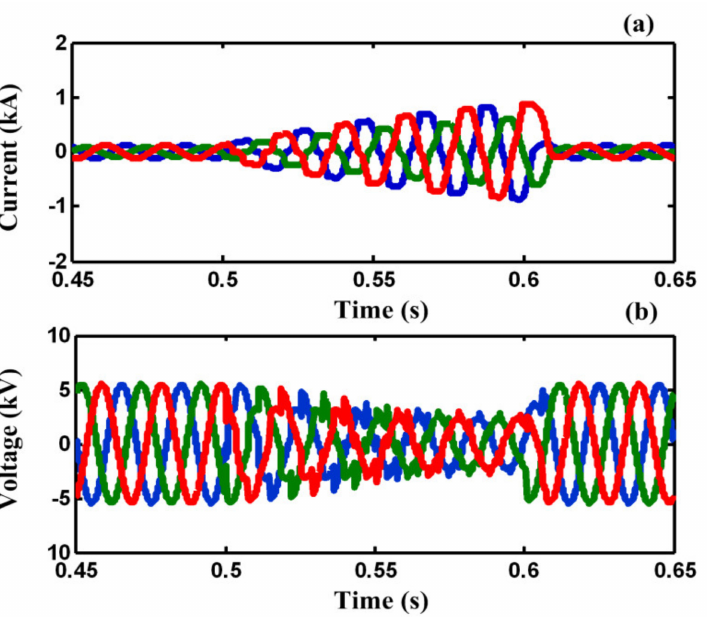
Figure 9. ( a ) Fault current in case B, ( b ) voltage of PCC in case